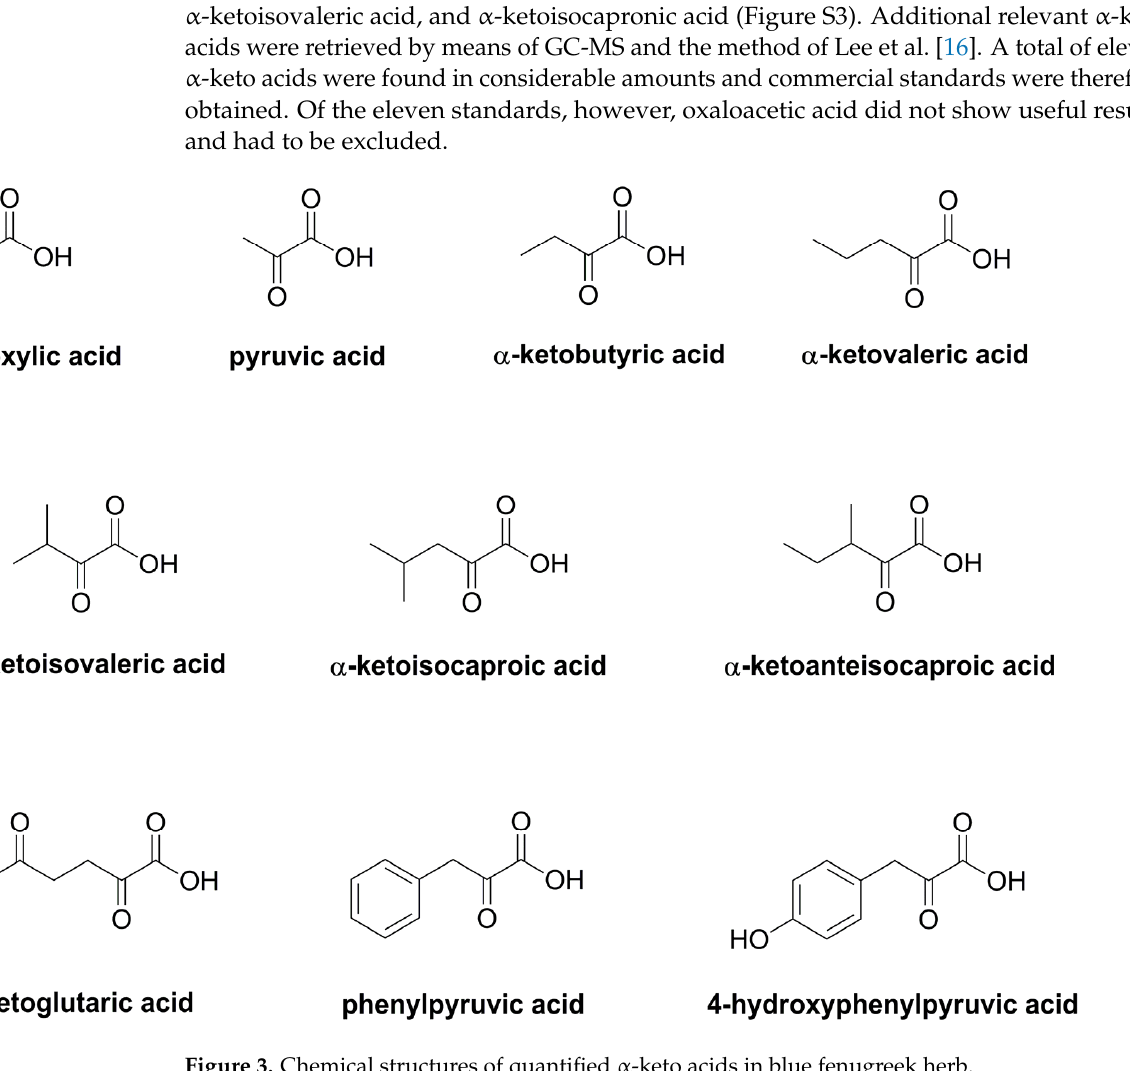
Figure 2. Chemical structures of analyzed fatty acids.